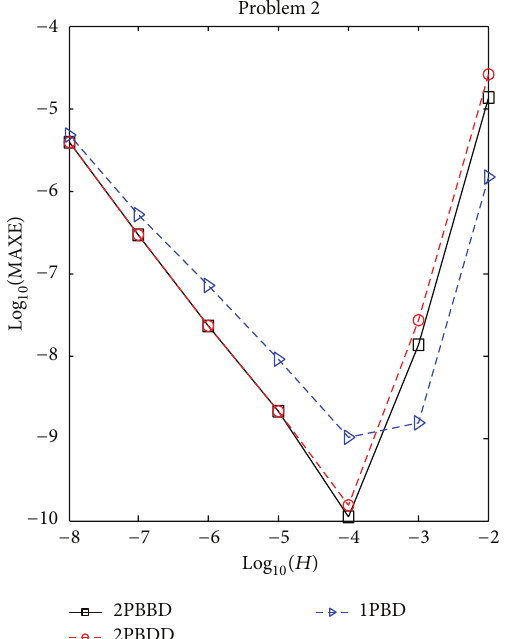
Figure 4: Graph of Log 10 ( MAXE ) plotted against Log 10 (𝐻) for Problem 2.